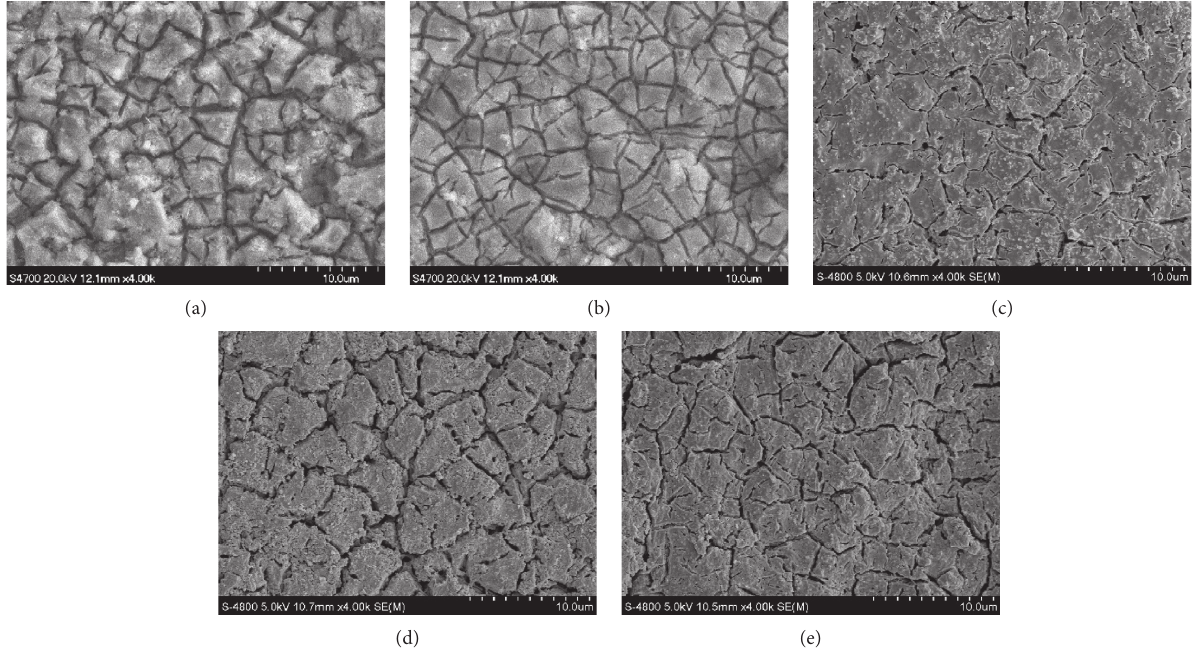
Figure 3: SEM images of Ti/SnO 2 -Sb-Ni/Eu electrodes with (a) Ni (0%), (b) Ni (1%), (c) Ni (2%), (d) Ni (3.5%), and (e) Ni (5%).